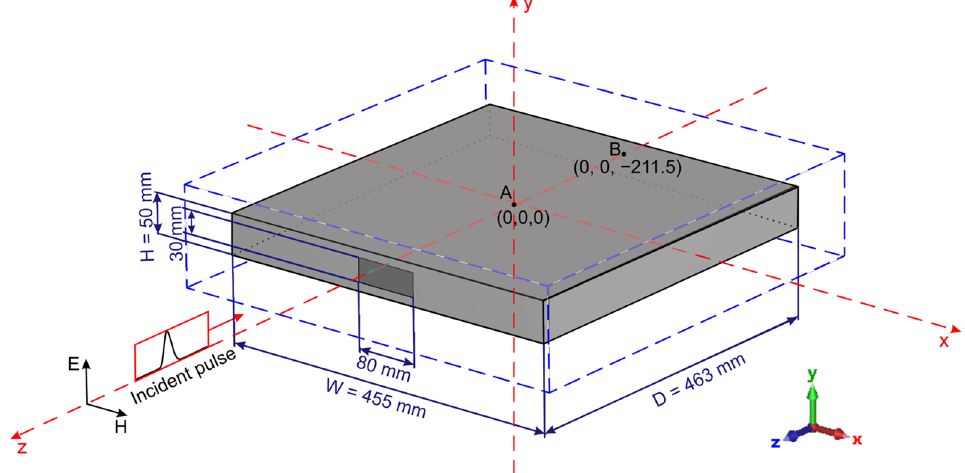
Figure 1. Dimensions of the enclosure with aperture in the rectangular coordinate system. The elec- tric field strength vector E(cid:4652)(cid:4652)⃗ is directed in the +y direction. The magnetic strength vector H(cid:4652)(cid:4652)⃗ is di- rected in the +x direction. Point A is the center of the enclosure. Local maxima of the electric and magnetic field strengths often occur at point B.